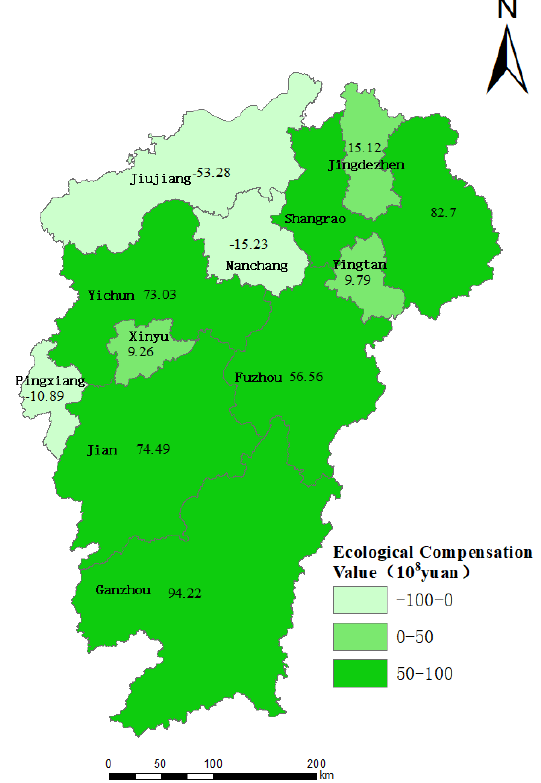
Figure 4. Spatial distribution map of total amount of ecological compensation standards for cultivated land resource assets.